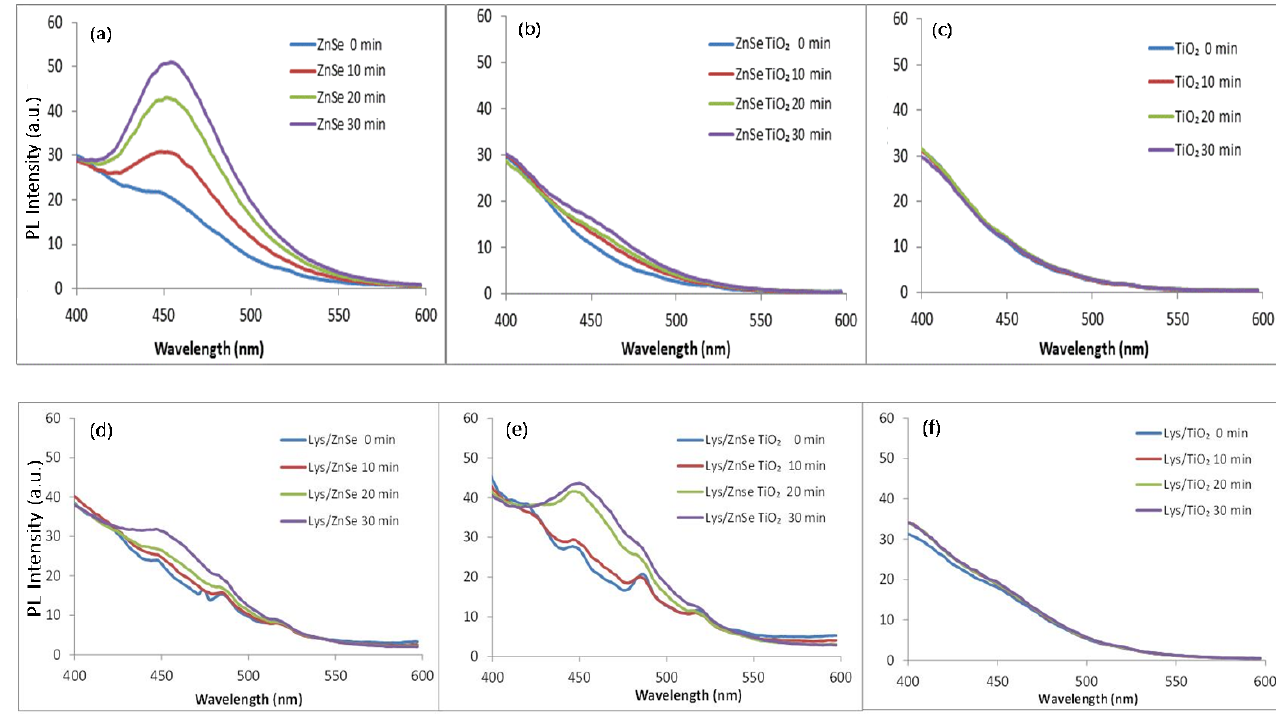
Figure 17. Generation of hydroxyl radical by inorganic ( a – c ) and lysozyme modified materials ( d – f ) under visible light irradiation.